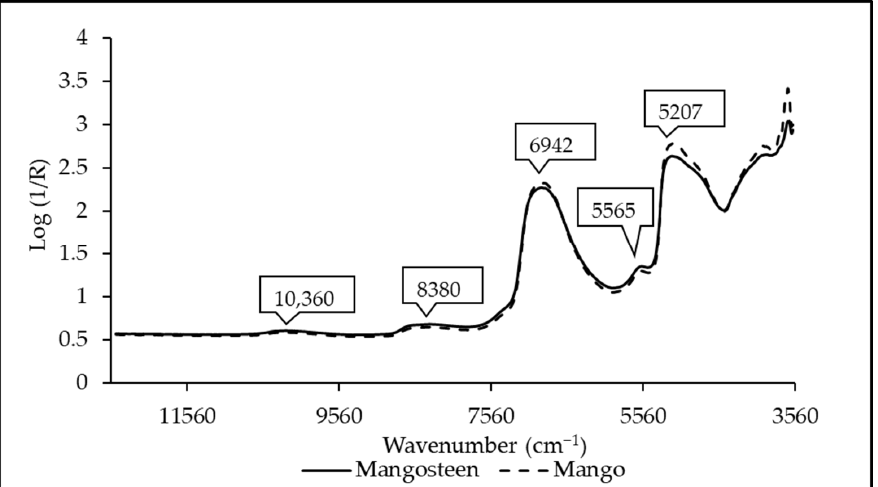
Figure 2. The average raw spectra of mango and mangosteen purée.